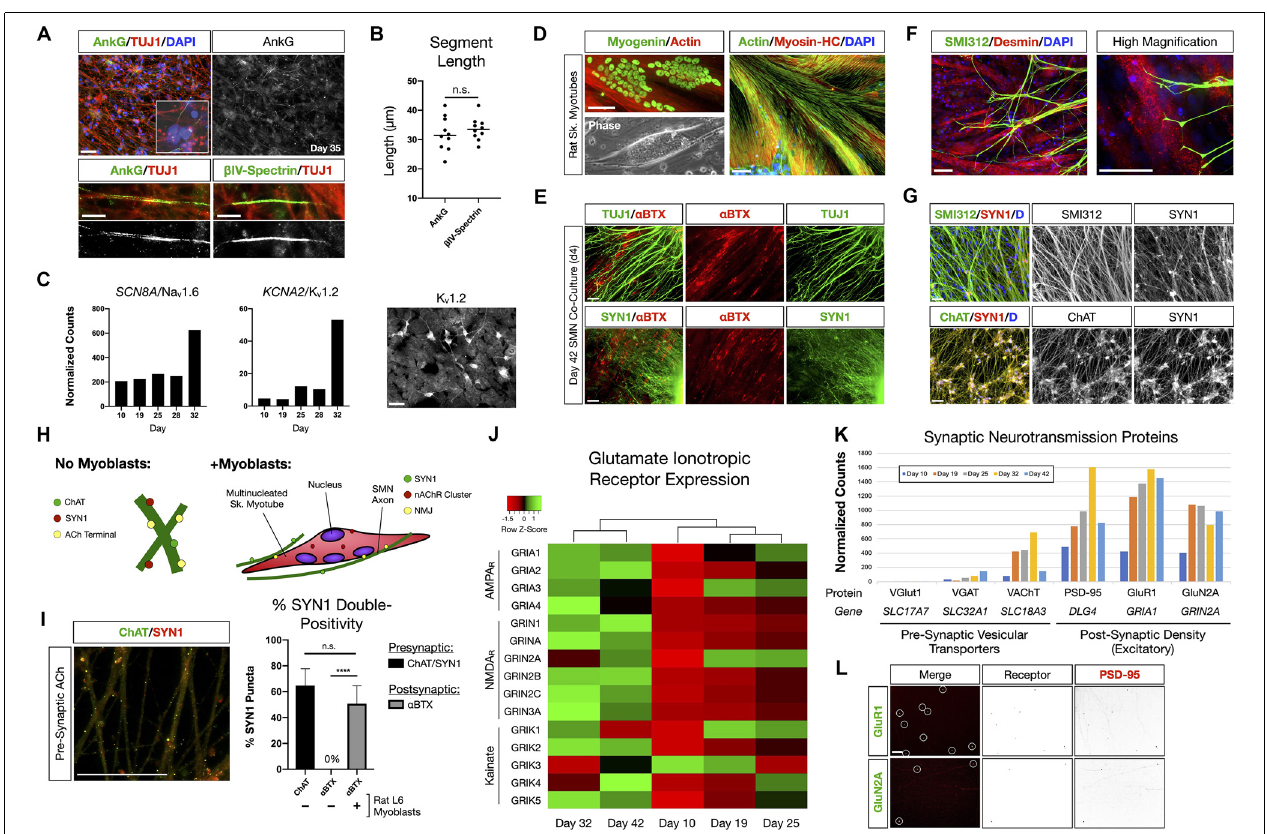
FIGURE 2 | NMP-derived SMNs are positive for axon initial segment proteins, assemble neuromuscular junctions, and develop characteristic synaptic profiles. (A) Maturing SMN-NS cultures exhibit short segments immunopositive for AIS proteins Ankyrin-G (AnkG) and β IV-Spectrin at day 35. Top: AnkG/TUJ1 counterstained with DAPI (nuclei). High-magnification image depicts AnkG+ staining distal to the soma. Bottom-left: AnkG immunopositive region along TUJ1+ filaments. Bottom-right: β IV-Spectrin immunopositive region along TUJ1+ filaments. (B) Length of AnkG (32 ± 2 µ m) and β IV-Spectrin (34 ± 1 µ m) segments by day 35 (two-tailed t test, t = 0.7082, df = 18, P = 0.4879, n = 10 segments measured per antibody). (C) Time course normalized expression of AIS-related voltage gated ion channels Na v 1.6 and K v 1.2 by RNA-Seq. IF showing cells positive for K v 1.2 on right. (D) Rat L6 multinucleated skeletal myotubes for NMJ formation assays. (E) Day 4 co-culture of SMN-NS (day 42) seeded onto rat myotubes. Top: TUJ1+ filament termination onto α BTX+ junctions (nAChR). Bottom: SYN1/ α BTX. (F) SMI312 axon termination in Desmin+ myotubes resembling early motor end plates. (G) Co-localization of cholinergic terminals (ChAT, bottom) with SYN1 puncta along axons (SMI312, top). (H) Cartoon diagram of ChAT/SYN1 pre-synaptic ACh terminals and nAChR post-synaptic machinery. (I) IF image and histogram of ChAT/SYN1 (64.7 ± 13.1%, n = 118 puncta) and SYN1/ α BTX co-localization in the absence (0%, n = 48 puncta) or presence (50.7 ± 13.8%, n = 69 puncta) of L6 myotubes (two-tailed t test, t = 10.36, df = 14, **** P < 0.0001). N = 8 fields were averaged for each condition. (J) Heatmap of glutamate ionotropic receptor expression (AMPA R , NMDA R , Kainate) during SMN differentiation. (K) Histogram of normalized gene expression for pre-synaptic vesicular transporters (VGlut1 excitatory, VGAT inhibitory, VAChT cholinergic) and post-synaptic density proteins/excitatory receptors. (L) Co-localization of AMPA R GluR1 (top) and NMDA R GluN2A (bottom) with scaffolding protein PSD-95. Individual channels provided as inverted LUT. Data are reported as mean ± s.e.m. Scale bars are 50 µ m, and 10 µ m in (A) high magnification images (bottom). n.s., not